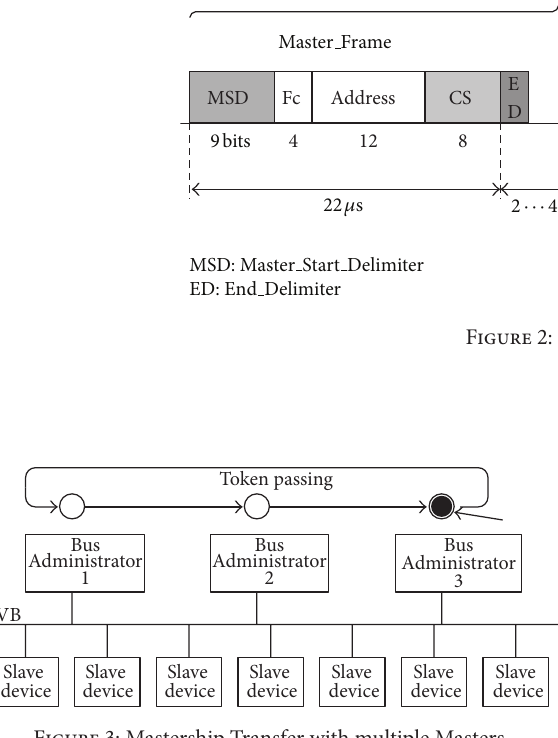
Figure 3: Mastership Transfer with multiple Masters.